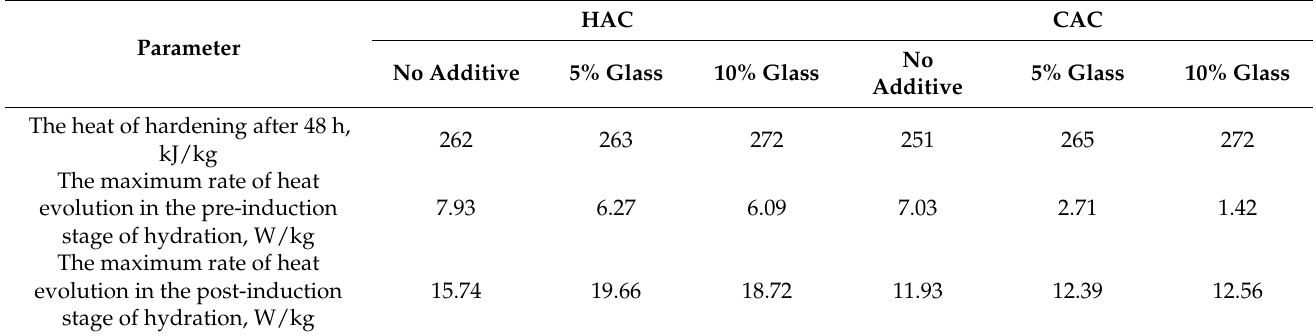
Table 3. The calorimetric characteristics of hydration of the tested types of cement (with and without glass). Parameter